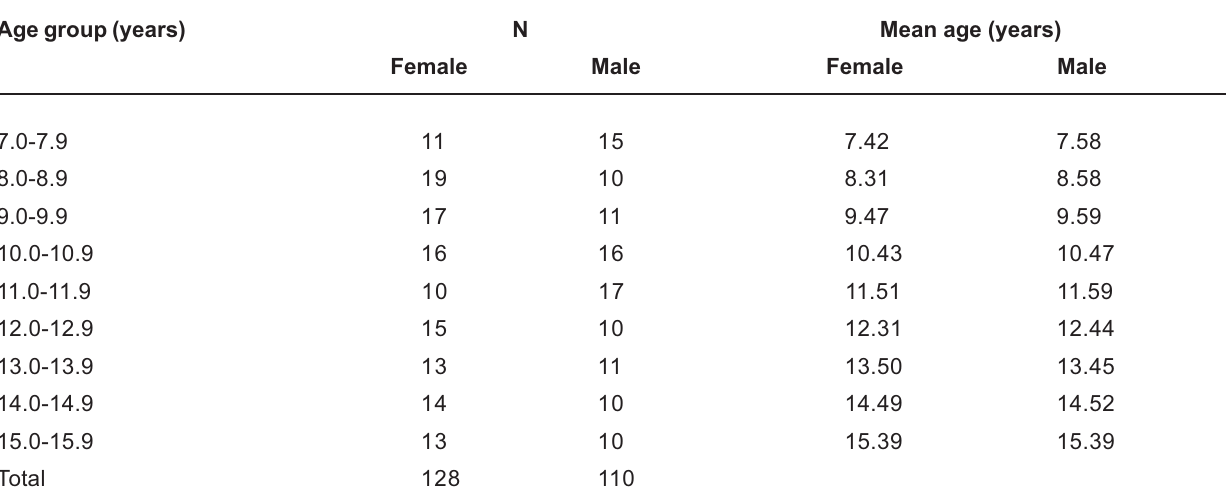
TABLE 1- Composition of the female and male